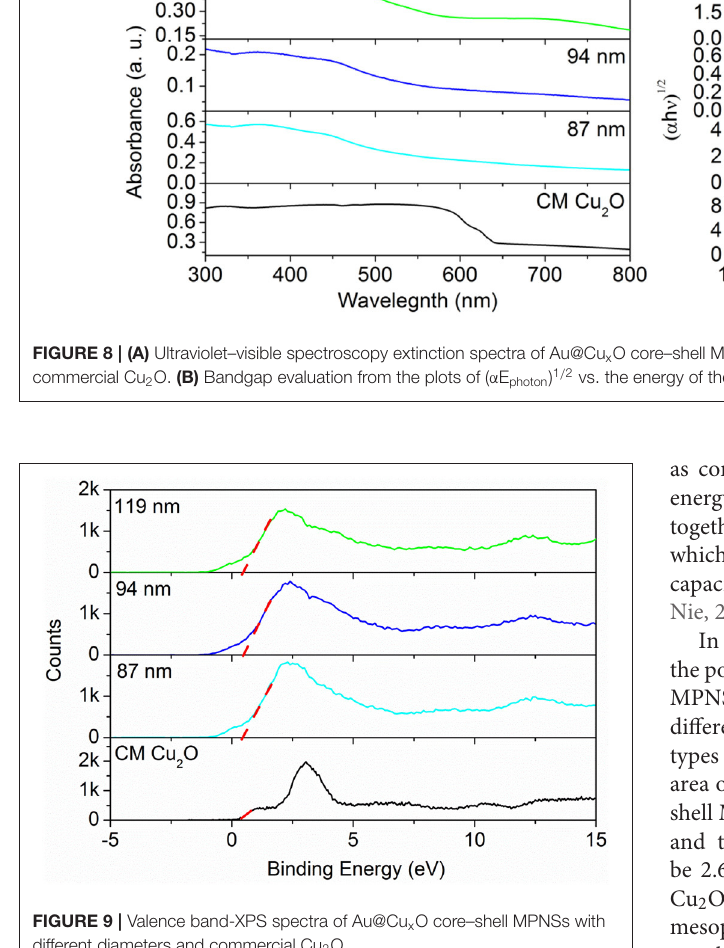
absorption gap was determined to be 1.97 eV (Jing et al.,